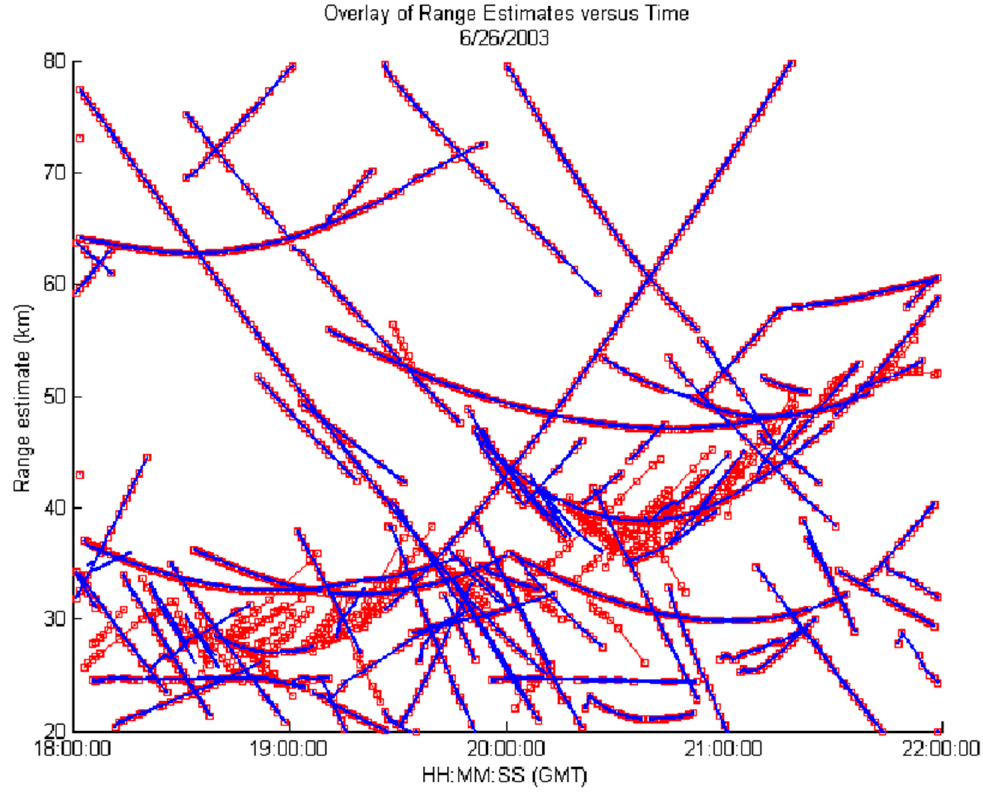
Figure 10. Range vs. time track overlay comparing fixed (red) and adaptive (blue) promotion logic tracking.